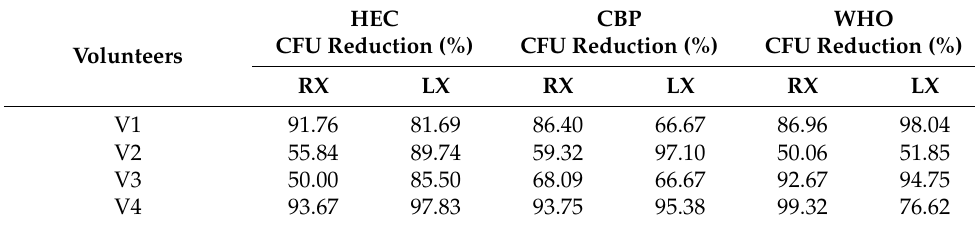
Table 8. CFU reduction in percentage (%) post-sanitization with the three formulations with respect to the baseline microflora of ten volunteers. For each subject, the CFU reduction (%) after treatment with the different hand sanitizers and the mean ± SD obtained from the data collected of the right and left hand of each volunteer for each formulation are